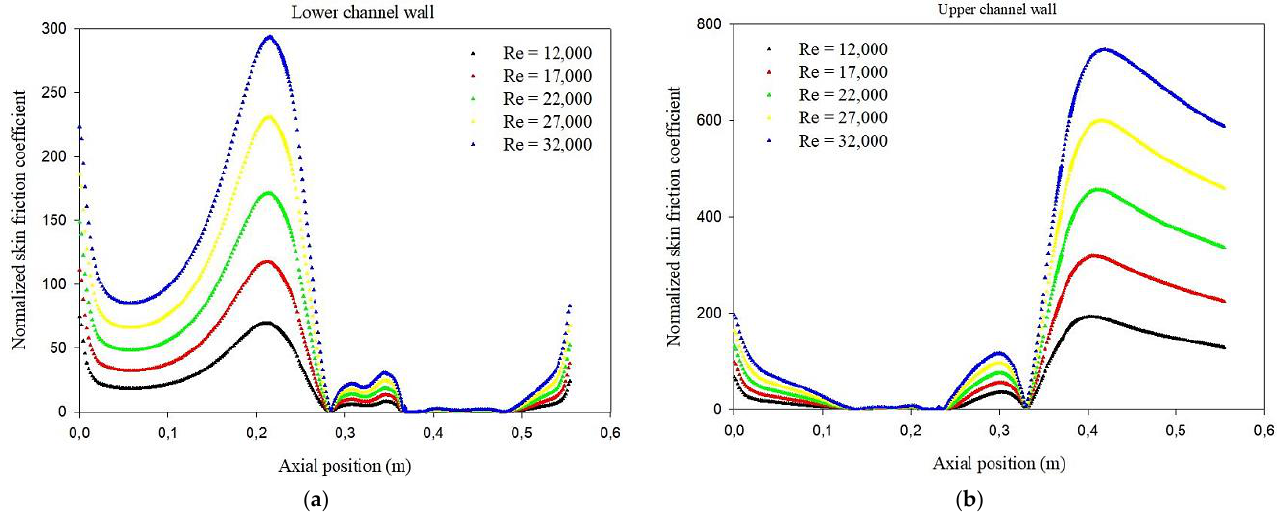
Figure 15. Changes in the dimensionless average skin friction coefficient on ( a ) lower; and ( b ) upper surfaces of the exchanger.